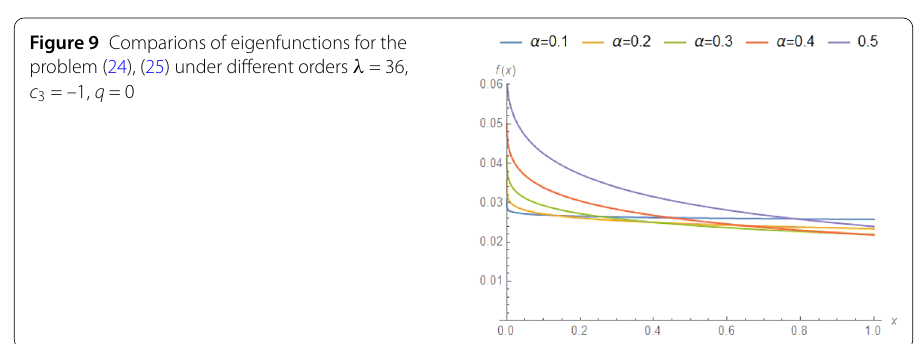
Figure 10 Comparions of eigenfunctions for the problem (30), (31) under different orders λ = 36, c 4 = –1, q = 0